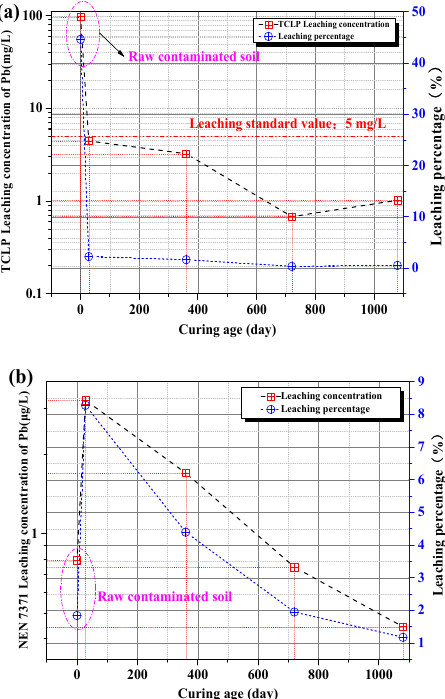
Figure 1. Leaching concentration of Pb from samples cured for different periods: ( a )TCLP; ( b ) NEN 7371 availability